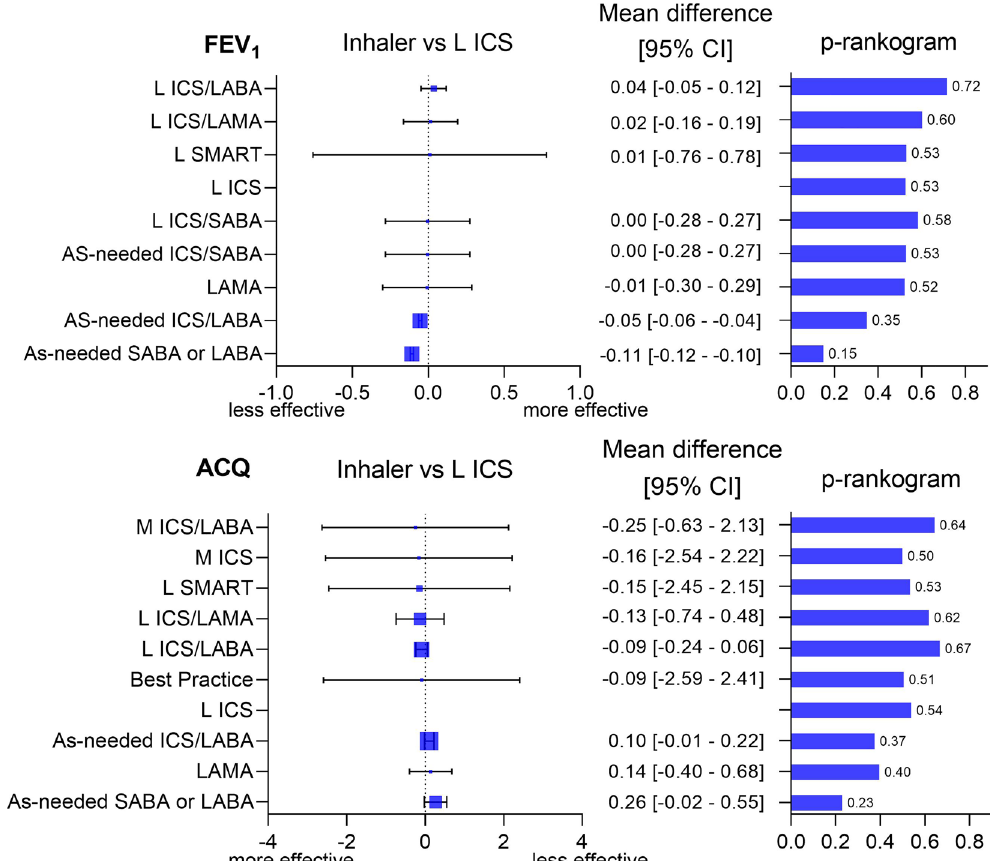
Figure 4. Forest plot and p-rankogram of all therapies for changes in forced expiratory volume in 1 s and Asthma Control Questionnaire. Each inhaler therapy is compared with low-dose inhaled corticosteroid as maintenance. A high score in p-rankogram indicates a more potent and reliable treatment. See Fig. 2 for